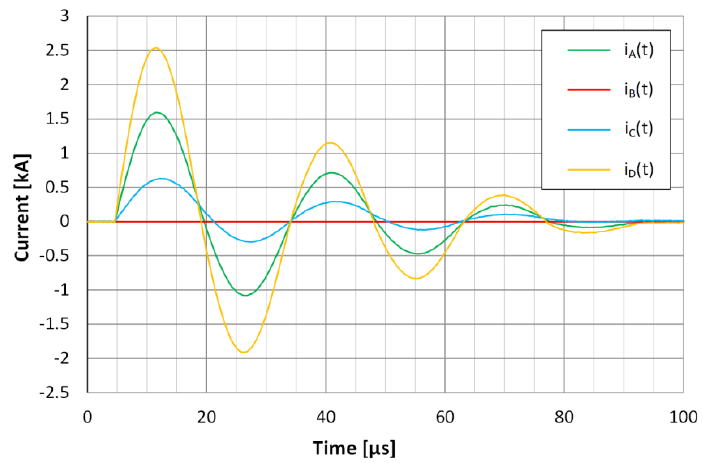
Figure 4. Current distribution in an aluminum calibration plate during one of the preliminary tests for the first solution of the test bench design. for the first solution of the test bench